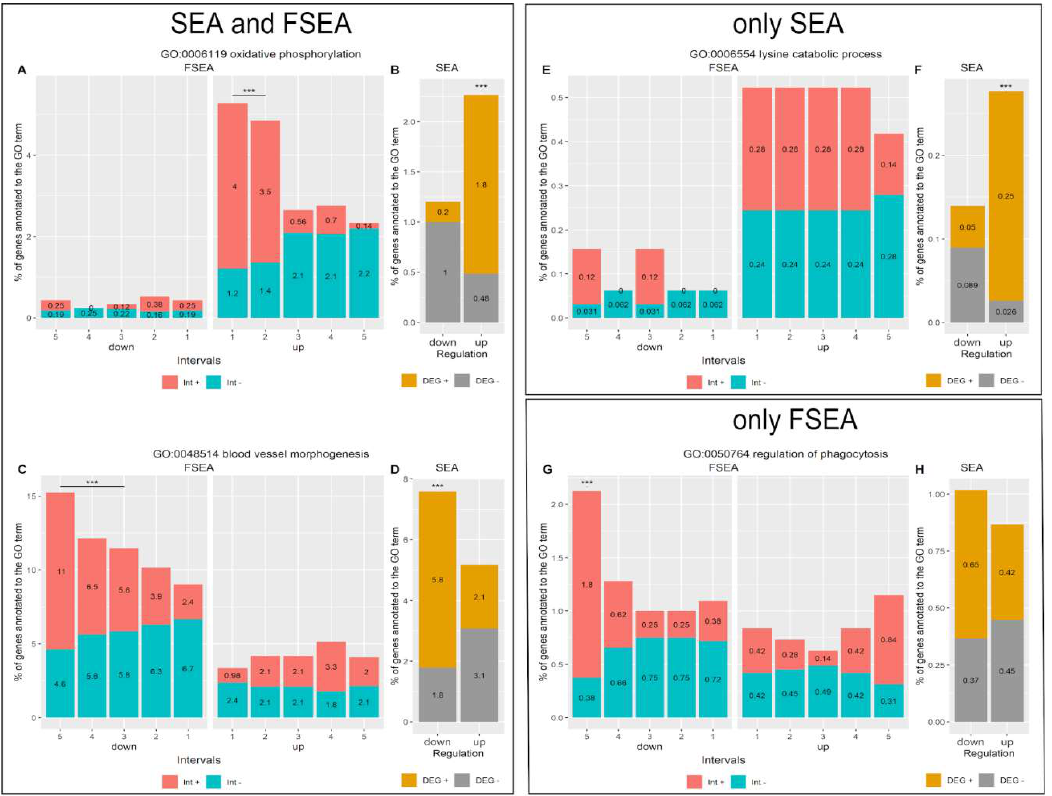
Figure 3. The response pattern of cancer-related processes identified in functional annotation of the LNCaP cell line in comparison to the HPrEC line as overrepresented by either Singular Enrichment Analysis (SEA) ( E , F ), or Fold-change-Specific Enrichment Analysis (FSEA) ( G , H ), or both ( A–D ). For each Gene Ontology (GO) term, we provide two histograms, A, C, E and G show FSEA output. Red-colored is the percentage of Differentially Expressed Genes (DEGs) related to the GO term and belonging to the fold-change interval compared to all DEGs in this interval; blue-colored is the percentage of DEGs out of the interval but related to the GO term among all DEGs out of the interval. Five-quantile FSEA marks the following intervals: 1—very weak response, 2—weak response, 3—moderate, 4—strong, and 5—very strong. Horizontal lines with asterisks denote the interval on which FSEA shows the significant enrichment of red-colored fractions versus blue ones. B, D, F, and H present the SEA output with (yellow colored) the percentage of DEGs annotated to the GO term in DEGs and (gray colored) the percentage of genes annotated to the GO term in not DEGs. Asterisks denote enrichment of yellow-colored fractions versus gray ones. A,B. Oxidative phosphorylation (GO:0006119). C,D. Blood vessel morphogenesis (GO:0048514). E,F. Lysine catabolic process (GO:0006554).